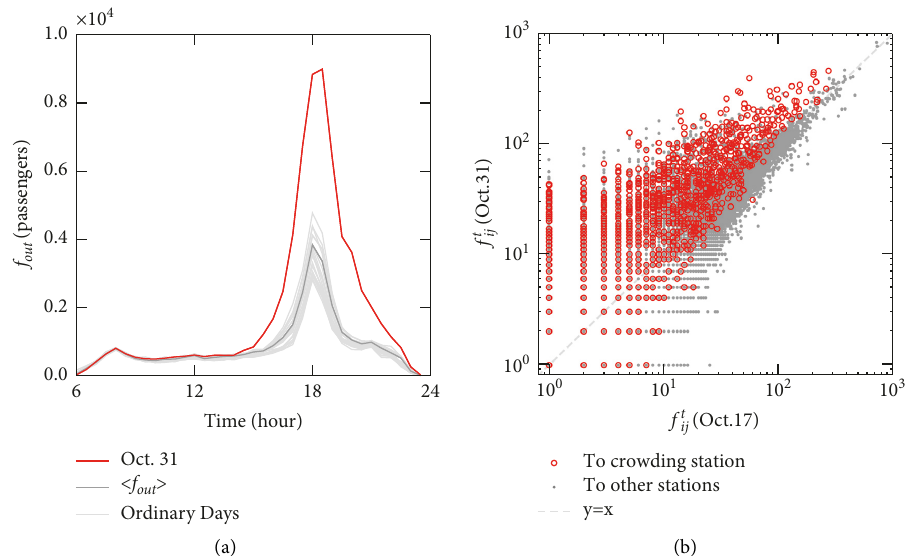
Figure 2: (a) The out-passenger flow f at the crowding station in ordinary days and the out-passenger flow f out the event day (i.e., October 31). (b) Passenger flow f t ij from station i to station j in time slot t . October 17 is an ordinary day and October 31 is the event day. Results in (b) are obtained during the time period of the crowding